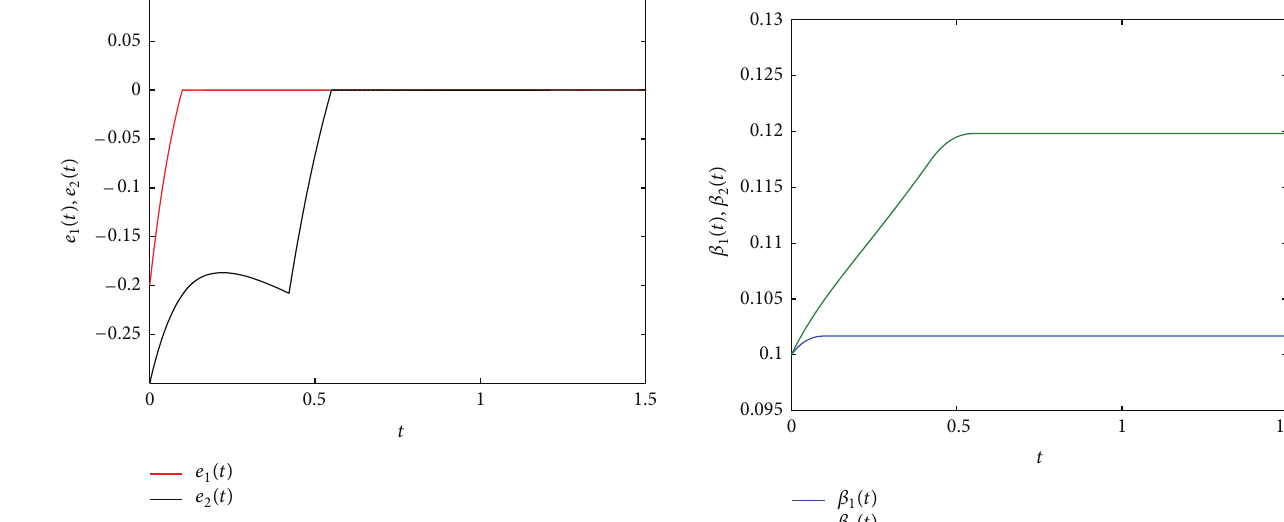
Figure 4: The synchronization errors 𝑒 1 (𝑡) and 𝑒 2 (𝑡) under the adaptive controller (42).